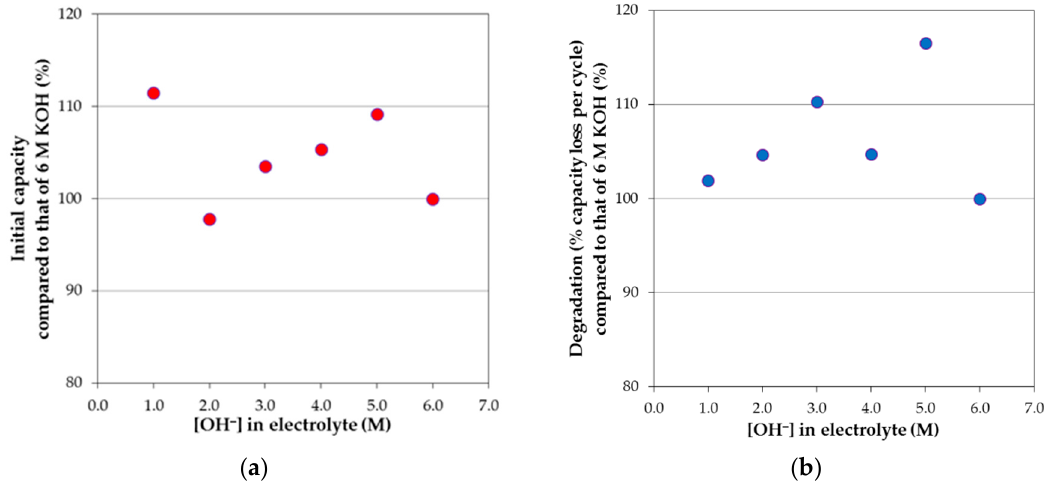
Figure 11. Plots of ( a ) the initial capacities and ( b ) degradation performances normalized to those of 6 M KOH aqueous solution vs. the total OH − concentration in solution for several pure KOH aqueous solution systems. Batteries 2016 , 2 , 27